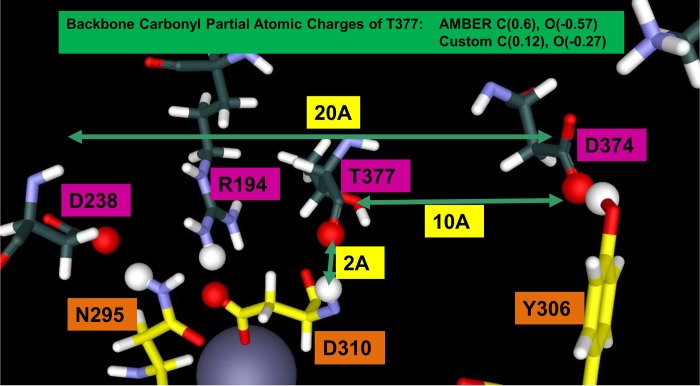
There is a dramatic change in polarization of the PCSK9 T377 backbone induced by LDLR binding.Standard partial charges from the Amber force field of a threonine carbonyl backbone are carbon (+0.60) and oxygen (-0.57). The GAMESS/RESP partial charges for the T377 of PCSK9 when interacting with LDLR-H306Y are carbon (0.12) and oxygen (-0.27), confirming that modeling indicates a profound and pervasive electron delocalization in this PPI.